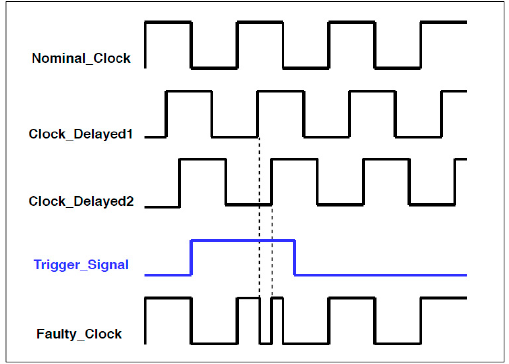
Figure 10. Faulty clock generation using two shifted signals [39].